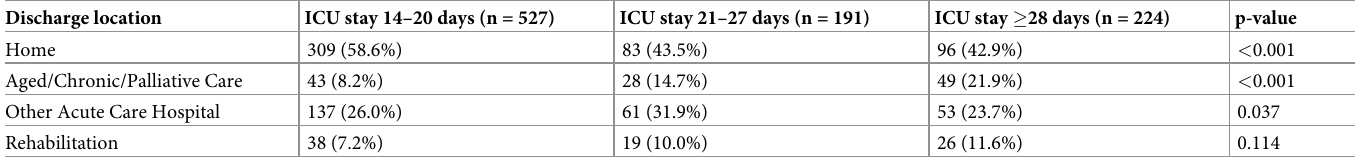
Table 2. Disposition of patients with prolonged ICU stay at hospital